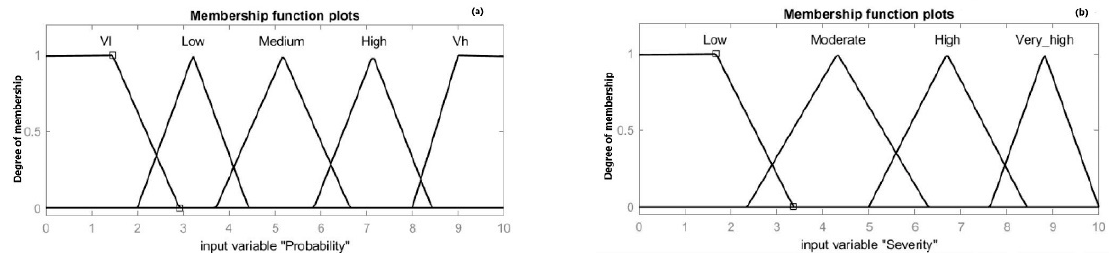
Figure 4. Membership functions of probabilities ( a ) and consequences ( b ) of risks based on experts’ judgments.